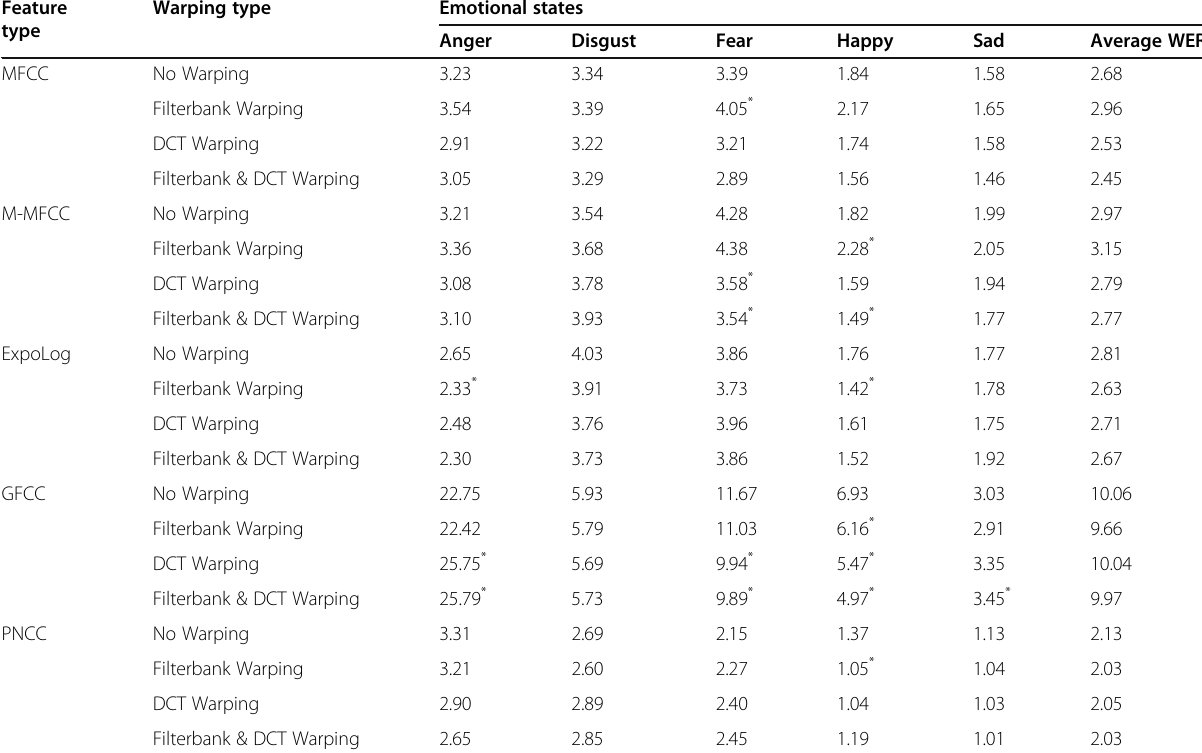
Table 6 The performance of the proposed DNN-HMM EASR system (in terms of WER (%)) for CREMA-D by applying different warping methods to various acoustic features and emotional states. The average WER values are given in the last column. The symbol * shows statistically significant cases (i.e., p value < 0.05)